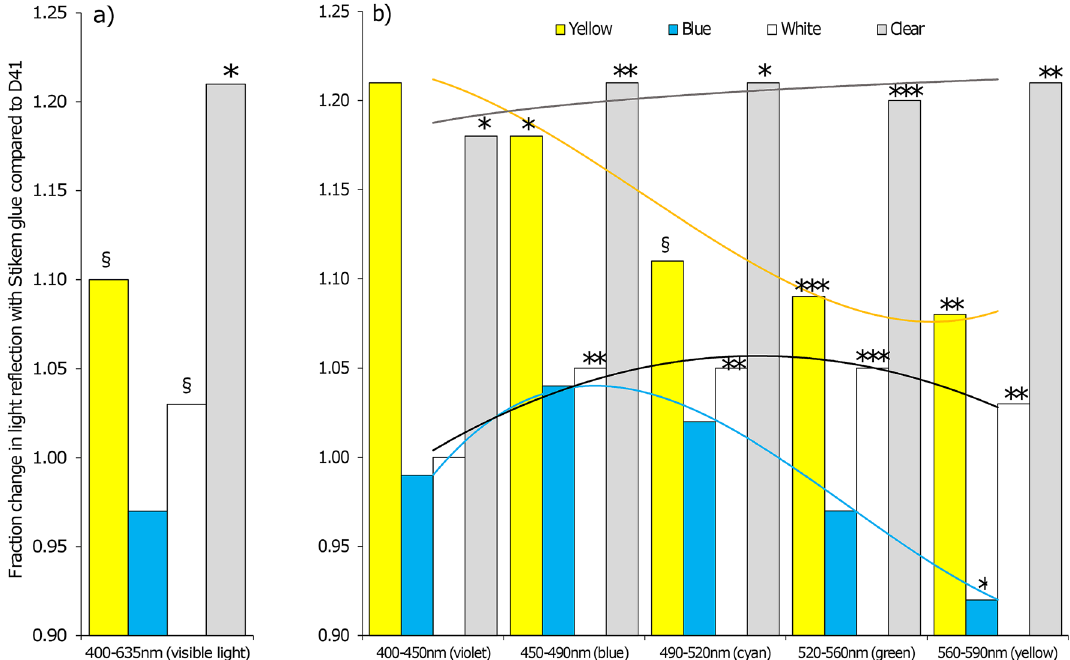
Figure 4. The reflection of D41 compared to Stikem glue calculated as the fraction (reflection of Stikem/ D41), shown for different plate colours of ( a ) the sum of thrips visible light and, ( b ) the different light spectra (N = 3). The measurements were performed in the wind tunnel and the reflection of the underlying data (not shown) was measured in quantum flux [μmol/(m 2 s)]. The percentage of change was considered to be significant ( § P < 0.1 trend, * P < 0.05, ** P < 0.01, *** P < 0.001) if the compared groups had different reflection. At significant fractions > 1, Stikem reflects more light than D41 and at < 1 it is vice versa. The statistical results were based on single t tests for the sum of visible lights ( a ) and a Sidak pairwise comparison of the interaction of a two- way ANOVA for glue, spectrum and interaction, for each plate colour ( b ). Test statistics, apart from symbols for significance are not shown. Trendlines for each colour plate are illustration of light reflectance shifts per wavelength group.